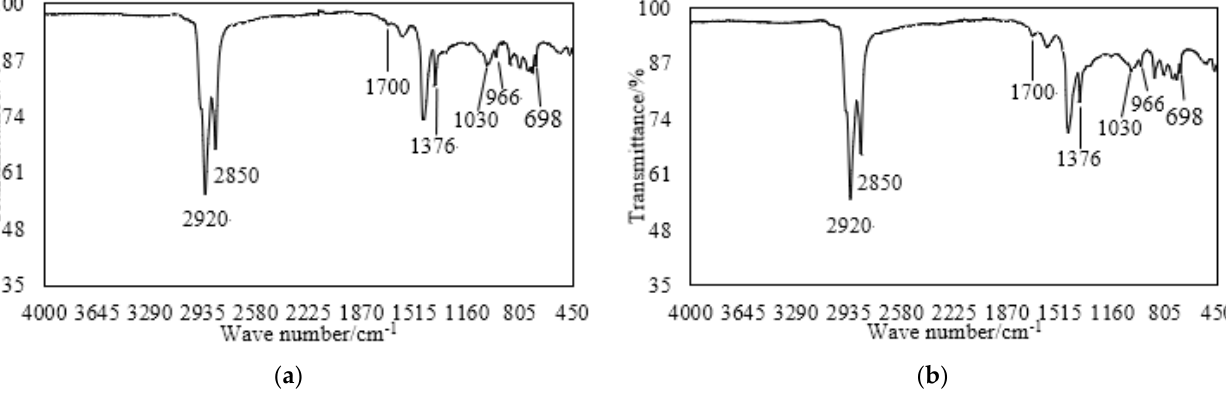
Figure 13. FTIR spectrum of asphalt extracted from long-term aged mixture: ( a ) BFSMA-13, ( b ) LFSMA-13.